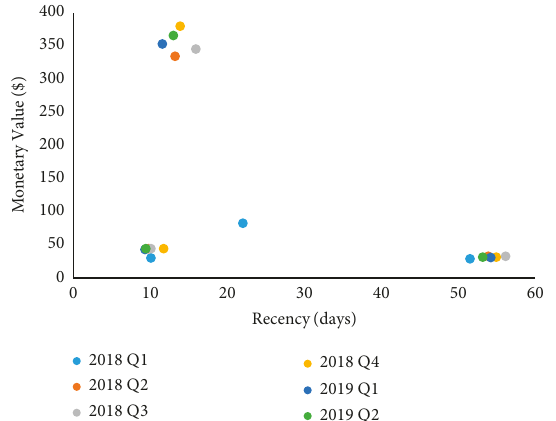
Figure 9: Target segment identification based on transit travellers’ recency ( R ) and monetary value ( M ). Points represent clusters 1, 2, and 3 for the 2018 and 2019